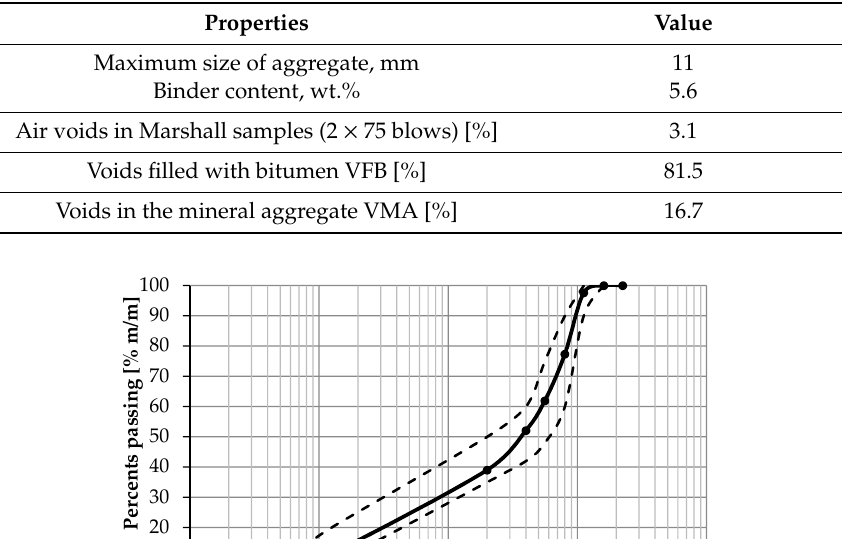
Table 3. Properties of the asphalt mixture.